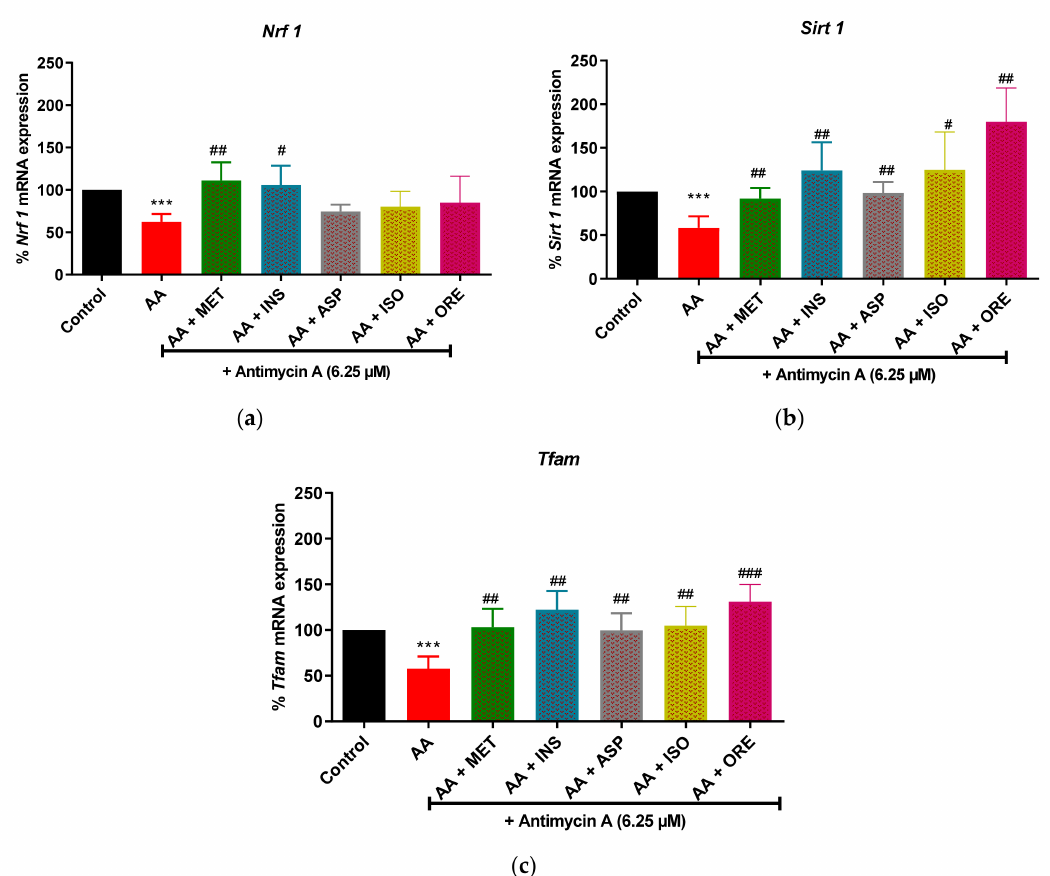
Figure 5. The effect of isoorientin and orientin on the expression of mitochondrial biogenesis genes; nuclear respiratory factor 1 ( Nrf 1 ; ( a )), Sirtuin 1 ( Sirt 1 ; ( b )), and mitochondrial transcription factor A ( Tfam ; ( c )) in C2C12 cells exposed to antimycin A. Cells were exposed to 6.25 µ M antimycin A for 12 h, followed by treatment with aspalathin, isoorientin, orientin (10 µ M) and comparative control metformin (1 µ M) for 4 h. Insulin (1 µ M) for 30 min. Results are expressed as mean ± SD of three independent experiments. *** p < 0.001 versus normal control; # p < 0.05, ## p < 0.01, ### p < 0.001 versus antimycin A